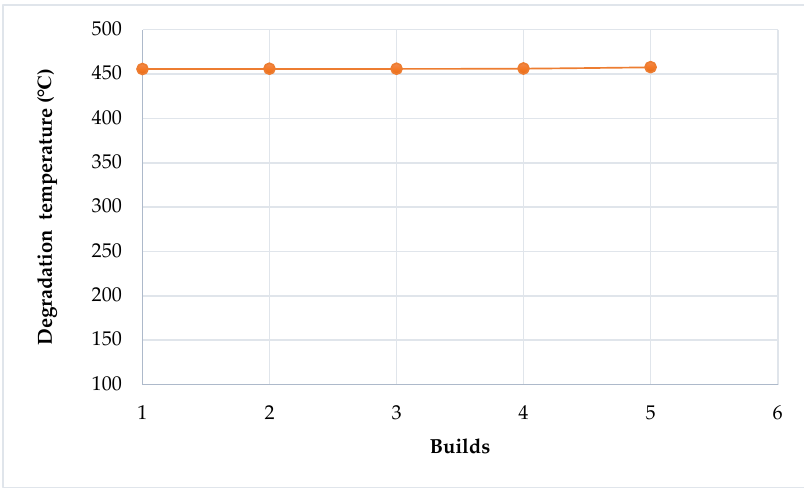
Figure 15. Degradation temperature of Laser PP CP 75 versus re ‐ use cycles. Table 9. Particle size distribution.